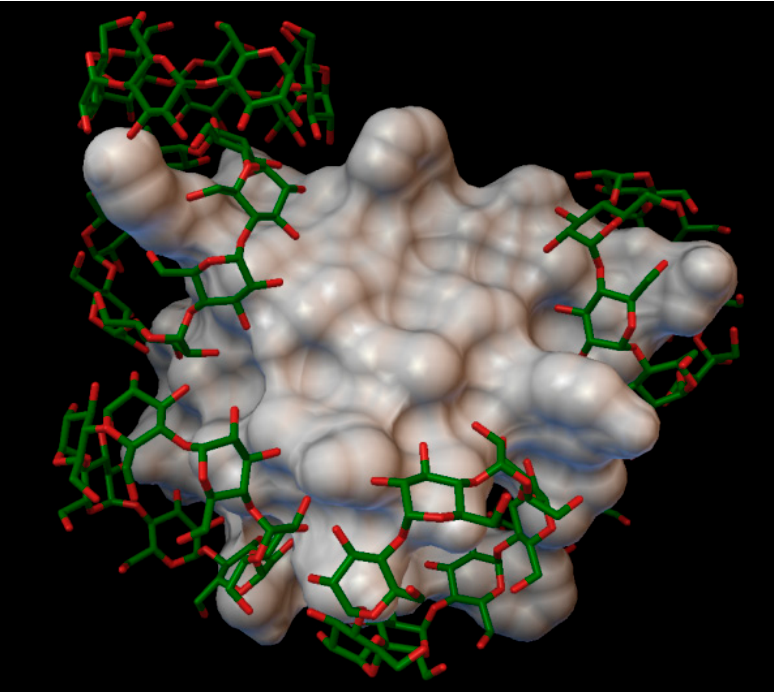
Figure 5. Insulin- β -cyclodextrin complex. The insulin molecular surface is marked with white and the cyclodextrin molecules are marked with green and red licorice.